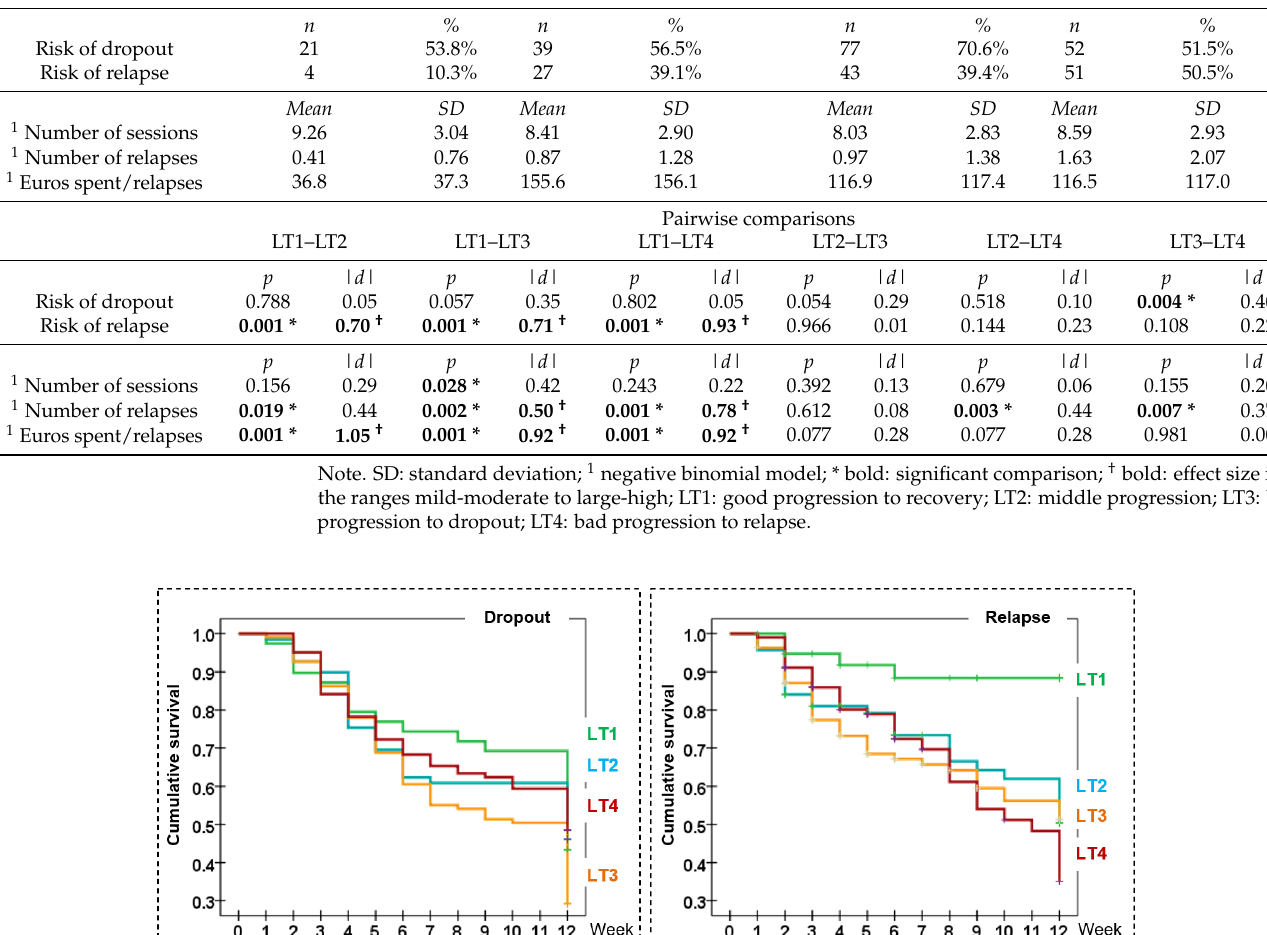
Figure 1 (LT1 was the group with the highest cumulative survival estimates for both these outcomes). Results of the Log Rank test achieved significant results for the cumulative survival curves for dropouts comparing LT1 versus LT3 (  2 = 3.99, p = 0.046) and LT1 ver- sus LT4 (  2 = 5.48, p = 0.019). For the relapses, Log Rank tests obtained significant results comparing LT1 versus the other latent classes (  2 = 9.99 and p = 0.002 compared to LT2,  2 = 11.14 and p = 0.001 compared to LT3, and  2 = 17.63, p < 0.001 compared to LT4). Based on the progression during the treatment, LT1 was labeled as “good progression to recov- Table 3. Comparison between the latent classes for the CBT outcomes. ery”, LT2 as “middle progression”, LT3 as “bad progression to dropout” and LT4 as “bad progression to relapse”. LT1; n = 39 LT2; n = 69 LT3; n = 109 LT4; n = 101 Table 3. Comparison between the latent classes for the CBT outcomes.